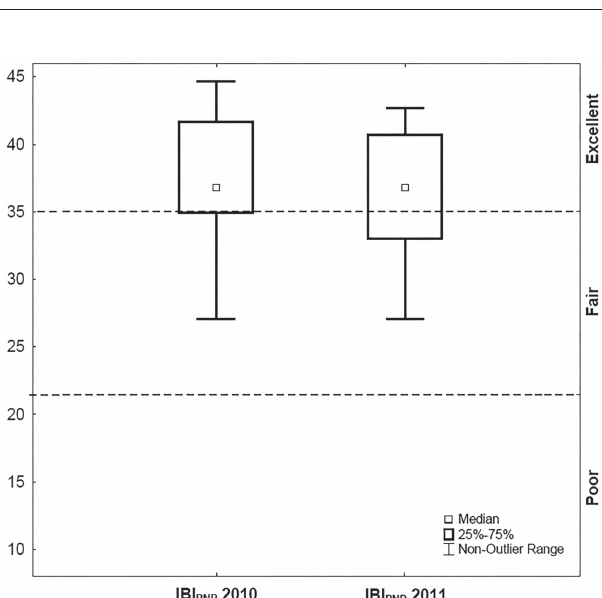
Fig. 2. Distribution of the IBI the Pantanal National Park during the dry season (Oct-Nov, 2010 and 2011). PB - permanent bays, TB - temporary bays, CR - corixos, MR - main rivers.